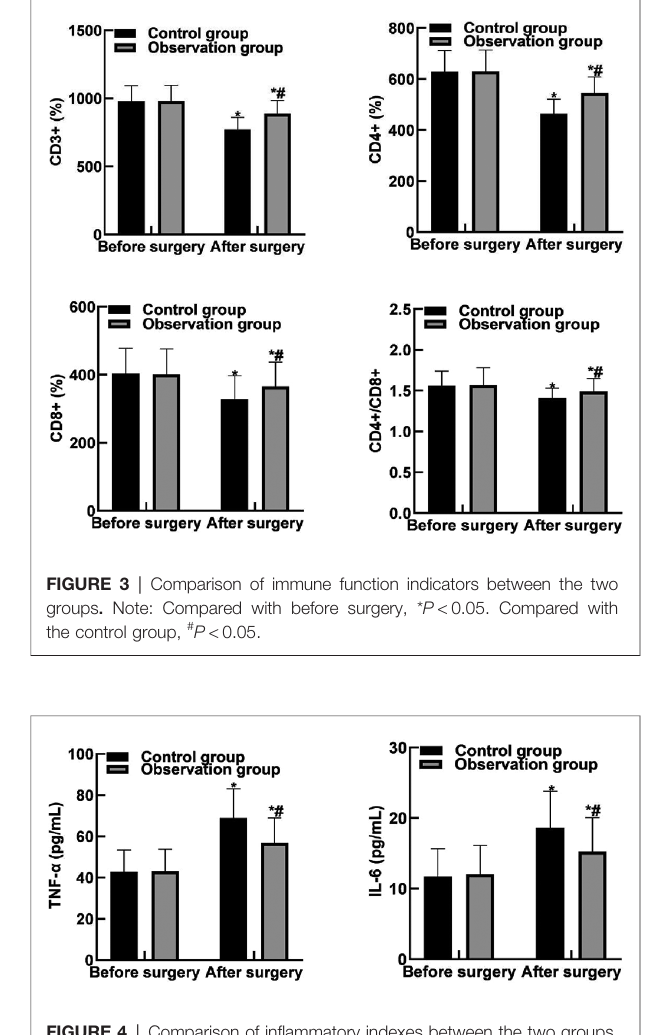
FIGURE 4 | Comparison of in fl ammatory indexes between the two groups . Note: Compared with before surgery, * P <0.05. Compared with the control group, # P